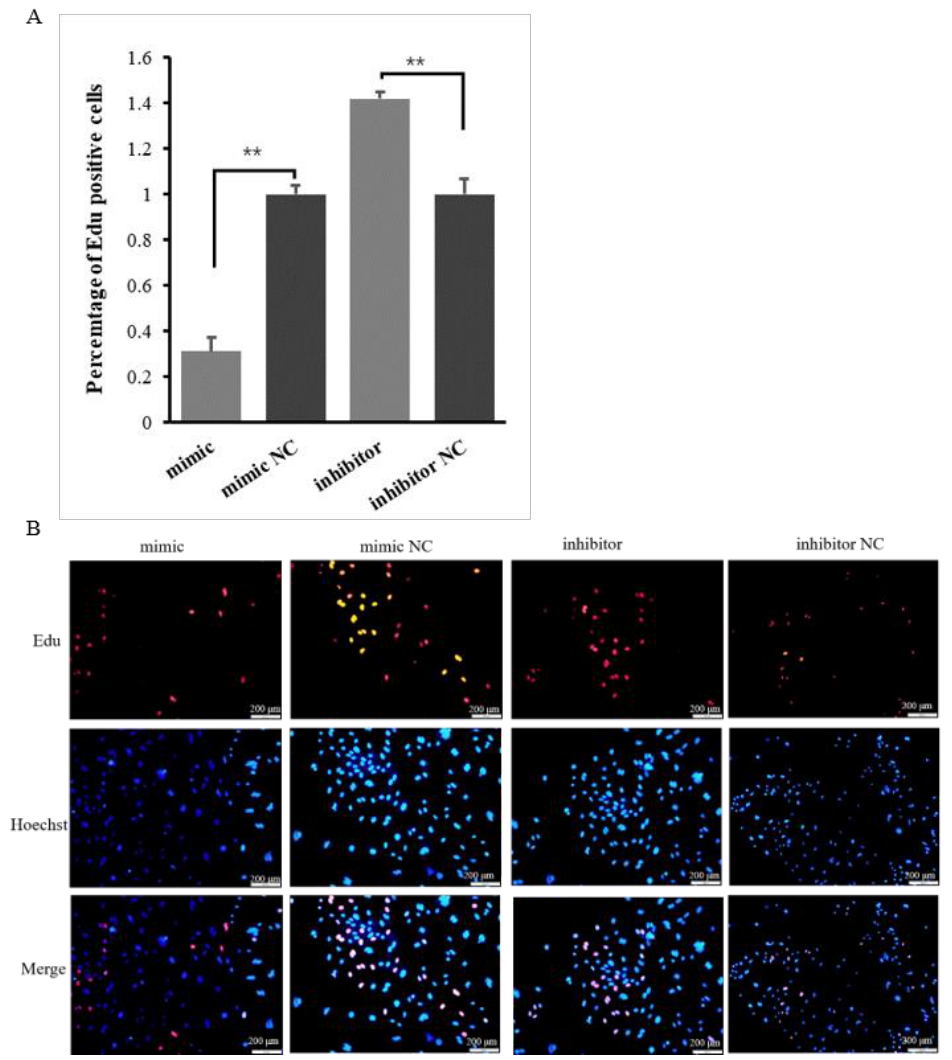
Figure 3. The effect of miR-200c on the proliferation of ovine MECs. ( A ) The proliferation of ovine MECs detected using Edu assay when miR-200c mimic and miR-200c inhibitor were transfected into ovine MECs. ** p < 0.01. ( B ) The Edu assay for detecting the proliferation of ovine MECs using a fluorescence microscope.